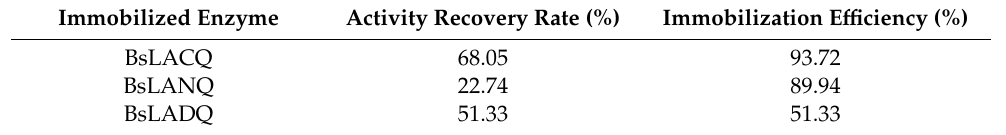
Table 1. The activity recovery rate and immobilization e ffi ciency of BsLA immobilized by SiO 2 -Fe 3 O 4 -NP [29]. Immobilized Enzyme Activity Recovery Rate (%)